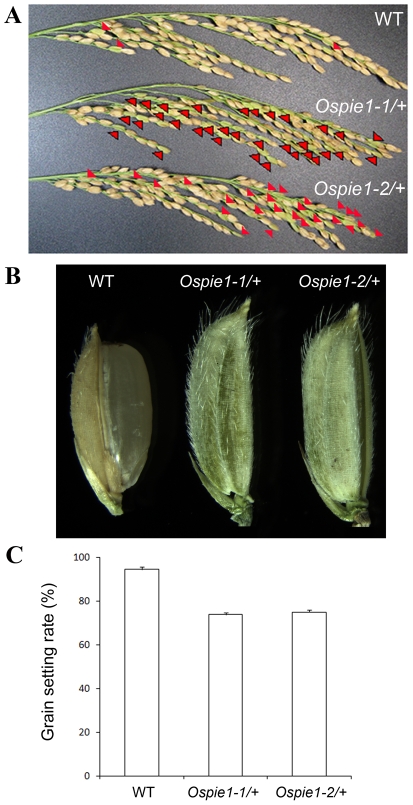
Phenotypic characterization of Ospie1 mutants.(A) Spikelets of self-pollinated wild-type (WT), Ospie1-1/+, and Ospie1-2/+. Red arrowheads indicate the panicels of abnormal empty seeds for each of the three genotypes. (B) Representative images of normal WT seeds and empty seeds from self-pollinated Ospie1-1/+ and Ospie1-2/+ plants. Half of the husk was removed for visualizing endosperms. No endosperm developed normally in those empty seeds of Ospie1-1/+ and Ospie1-2/+ plants. (C) Quantitative analysis of grain setting rates for heterozygous Ospie1 plants. Grain setting rate is the percent of filled grains over the sum of filled and empty grains for each plant. Data shown are means ± SD of 30 plants for each genotype. The experiment was repeated three times, with a similar result.